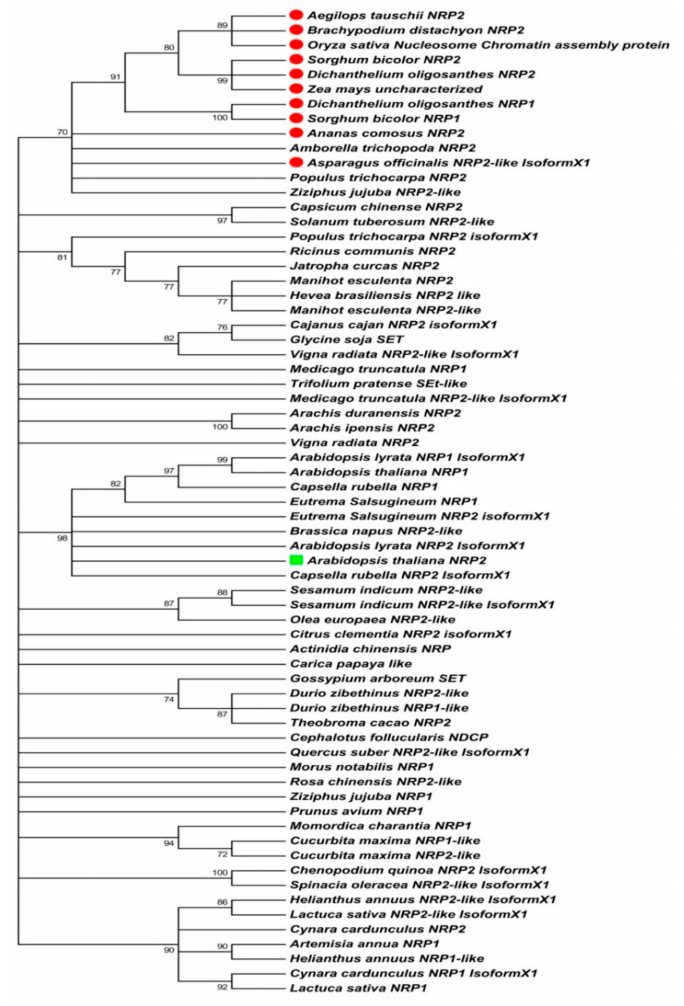
Figure 1. Molecular phylogenetic analysis of NAP1-Related Proteins (NRPs) by maximum likelihood method. The evolutionary history was inferred by using the maximum likelihood method based on the Poisson correction model. The bootstrap consensus tree derived from 1200 replicates was taken to represent the evolutionary history of the taxa analyzed. Branches corresponding to partitions reproduced in less than 70% bootstrap replicates were collapsed. The percentage of replicate trees